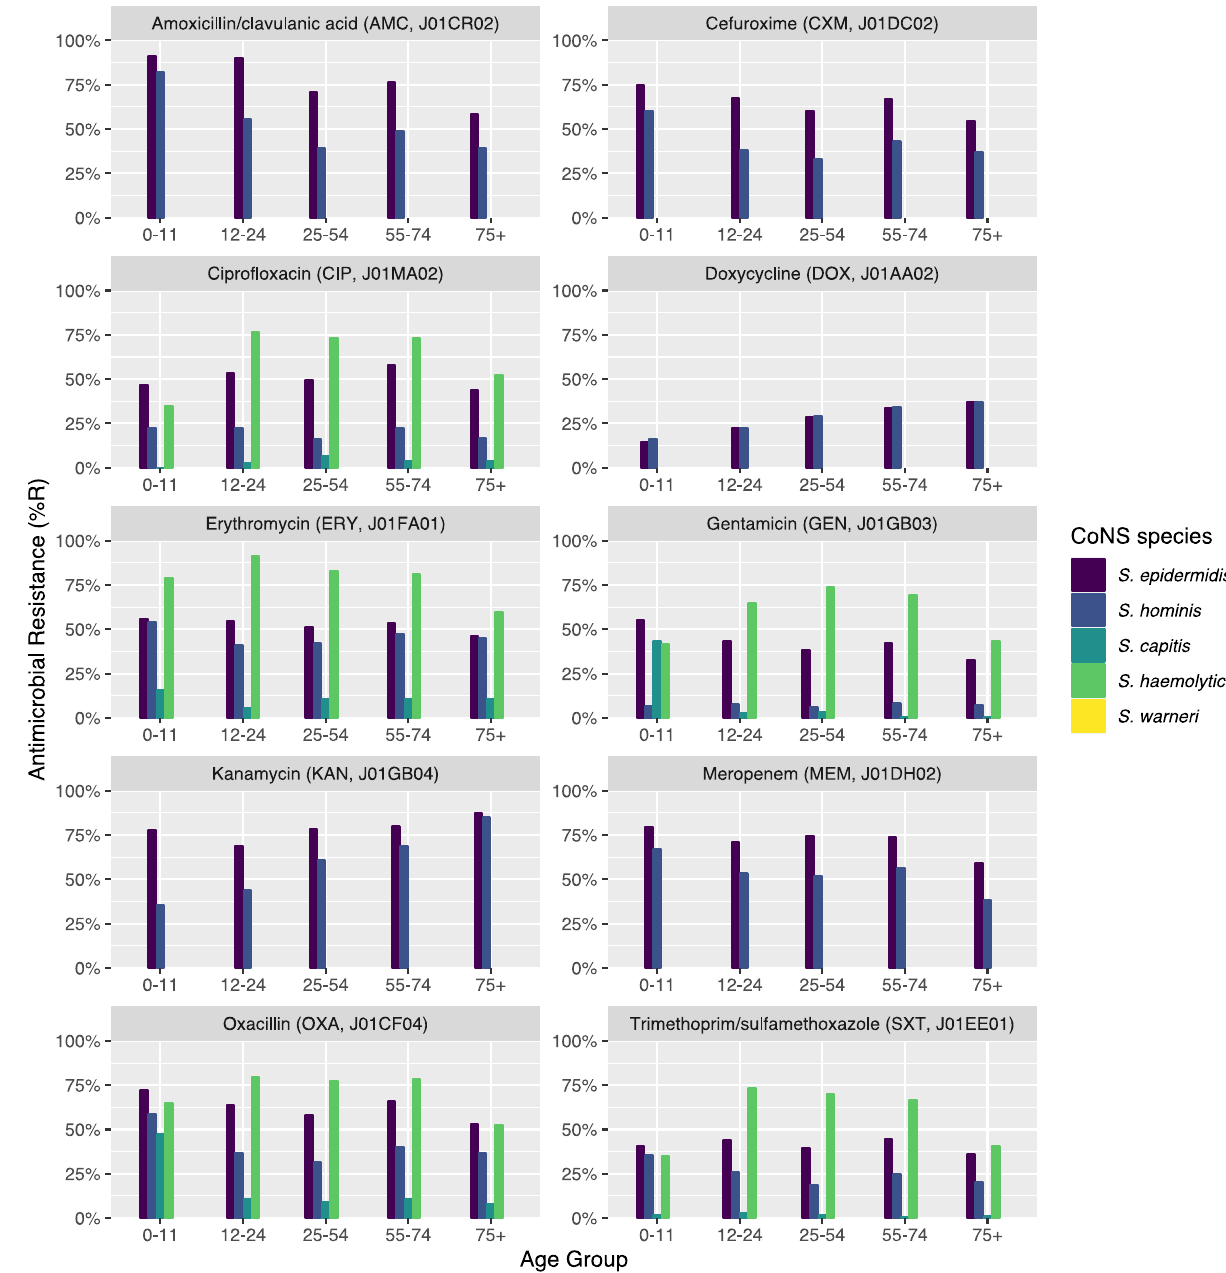
Figure 4. Age group comparison of ABR per antibiotic. Only microorganism-drug combinations are shown where at least 30 isolates were available for each age group and where results for all age groups were available.